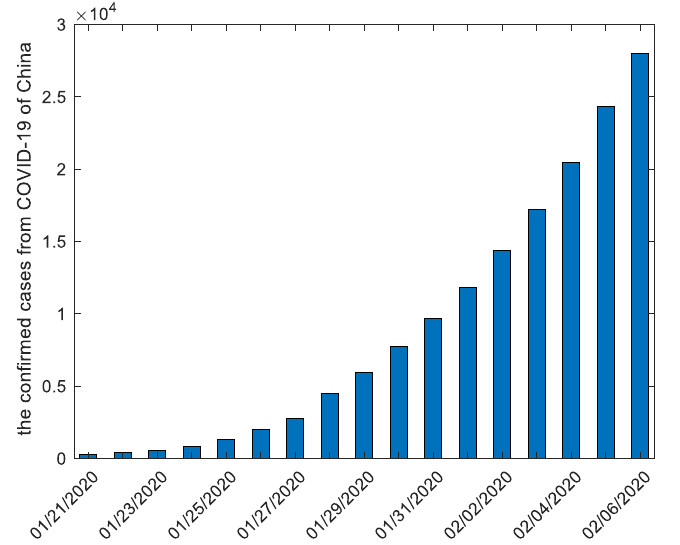
Figure 3. The plots of the confirmed cases from COVID-19 of China.